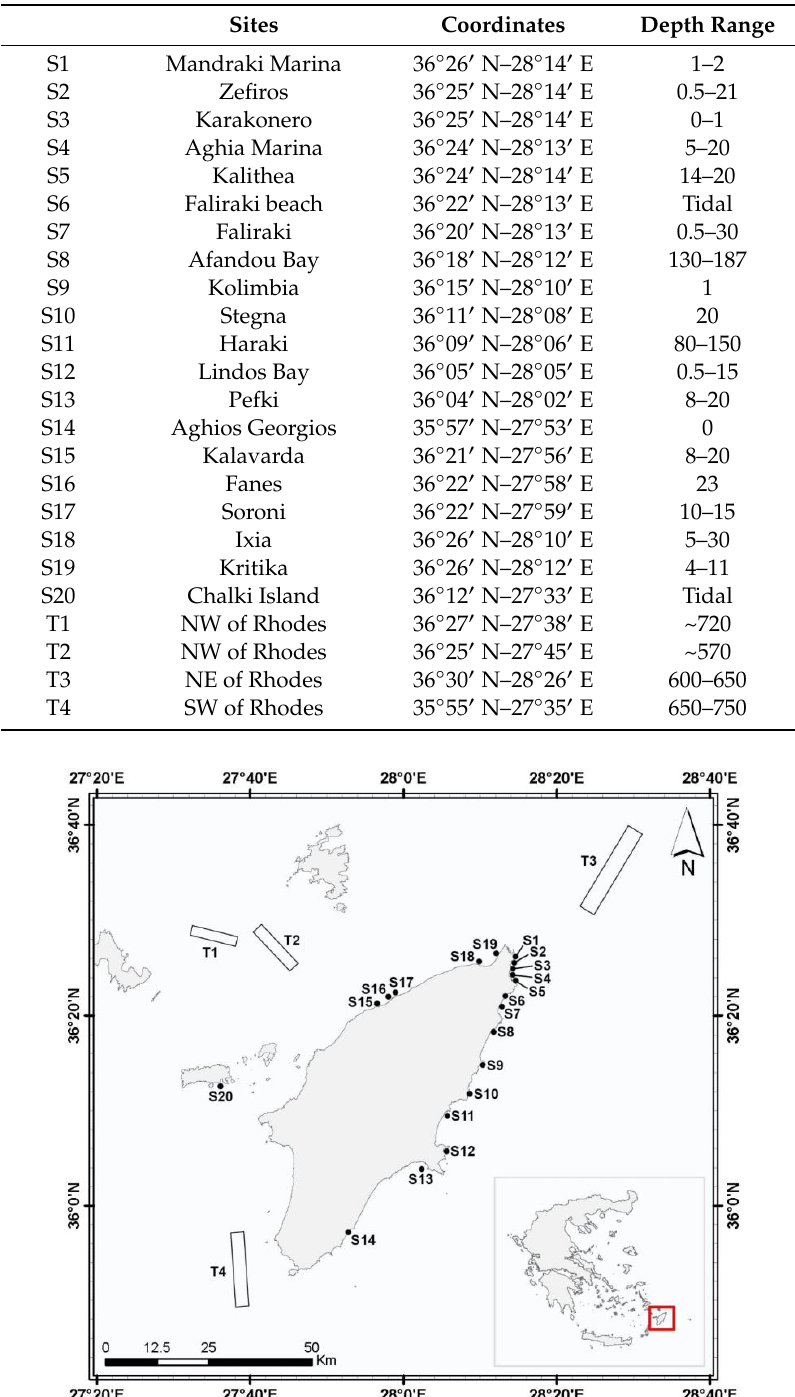
Figure 1. Study area with the location of Rhodes Island within Greece (red square). Sampling sites